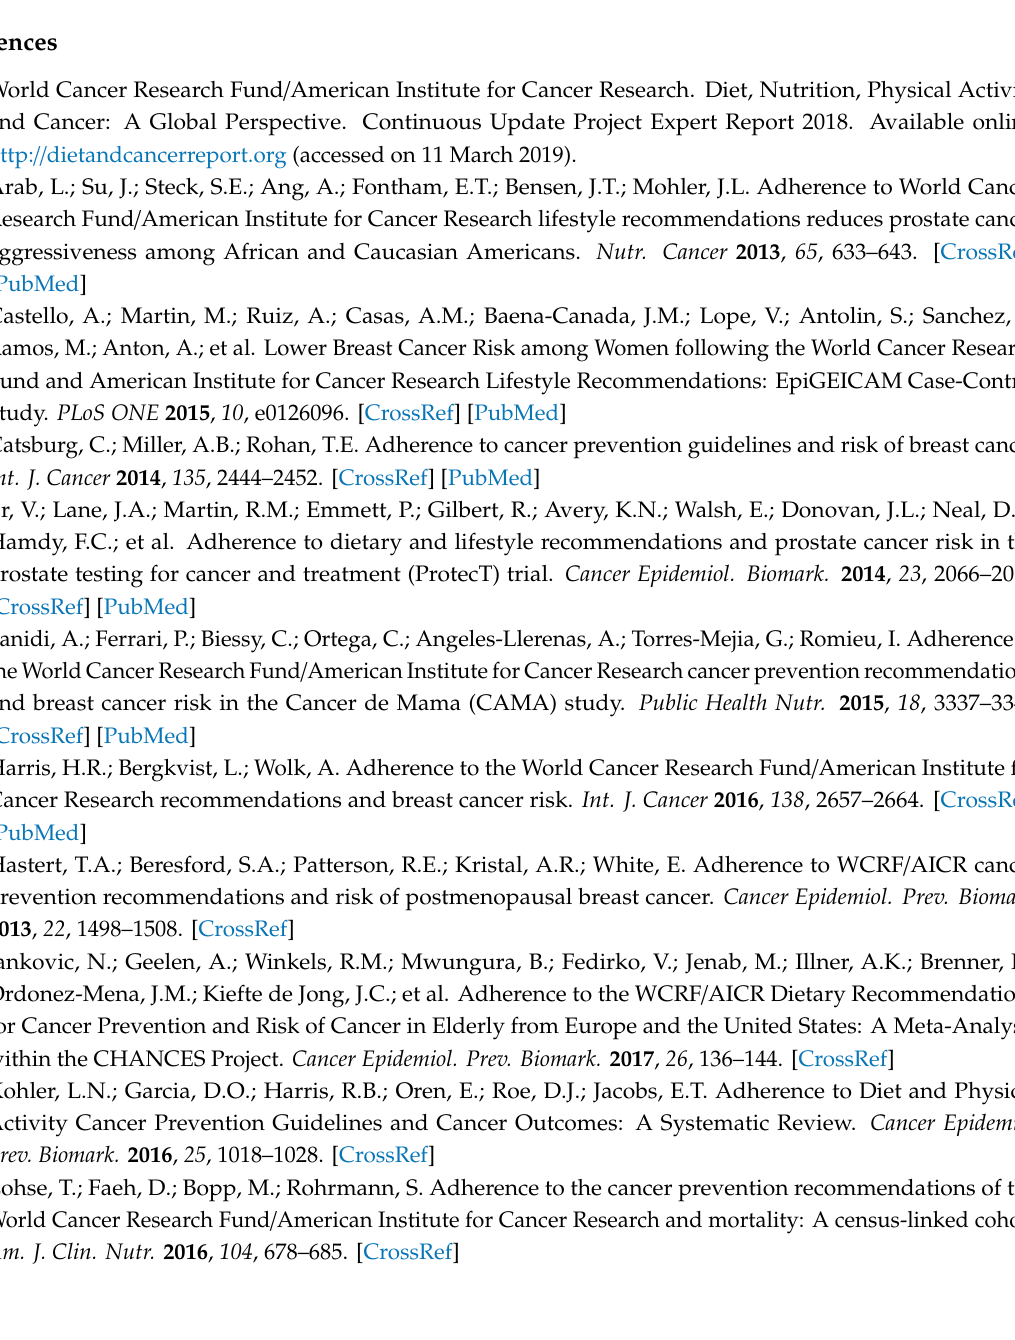
Figure S1: Ultra-processed foods (UPFs) included to create the adapted ultra-processed food variable (aUPF) in the NIH-AARP Diet and Health Study dataset, Table S1: Distribution of percent total energy from UPFs vs. aUPFs in the NIH-AARP Diet and Health Study ( N =